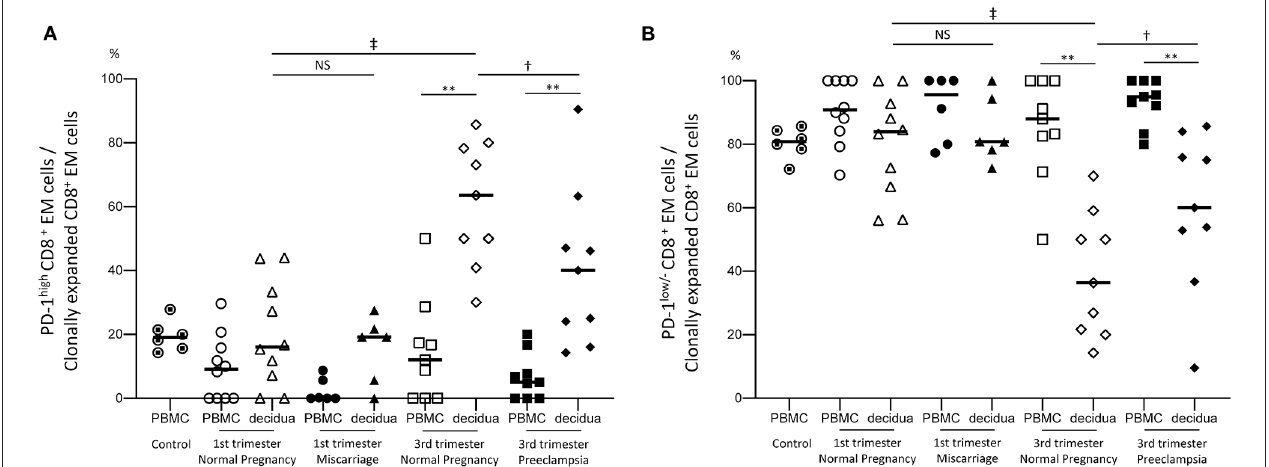
FIGURE 5 | PD-1 high and PD-1 low / − CD8 + EM cell populations. (A) PD-1 high CD8 + EM cells among clonally expanded CD8 + EM cells. (B) PD-1 low / − CD8 + EM cells among clonally expanded CD8 + EM cells. Statistical analysis was performed using Wilcoxon matched-pairs single rank test (PBMC vs. decidua in each group); ** p < 0.01. Mann-Whitney U-test (1st vs. 3rd trimester normal pregnancy, 1st trimester normal pregnancy vs. miscarriage, 3rd trimester normal pregnancy vs. preeclampsia); † p < 0.05; ‡ p < 0.01; NS, not